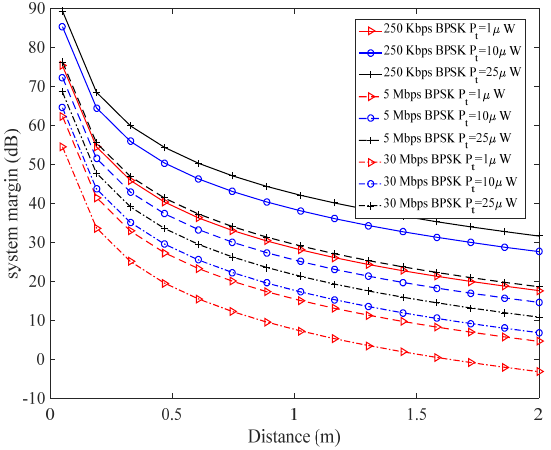
Figure 6. Link margin versus distance using BPSK at multiple levels of data rates and powers.